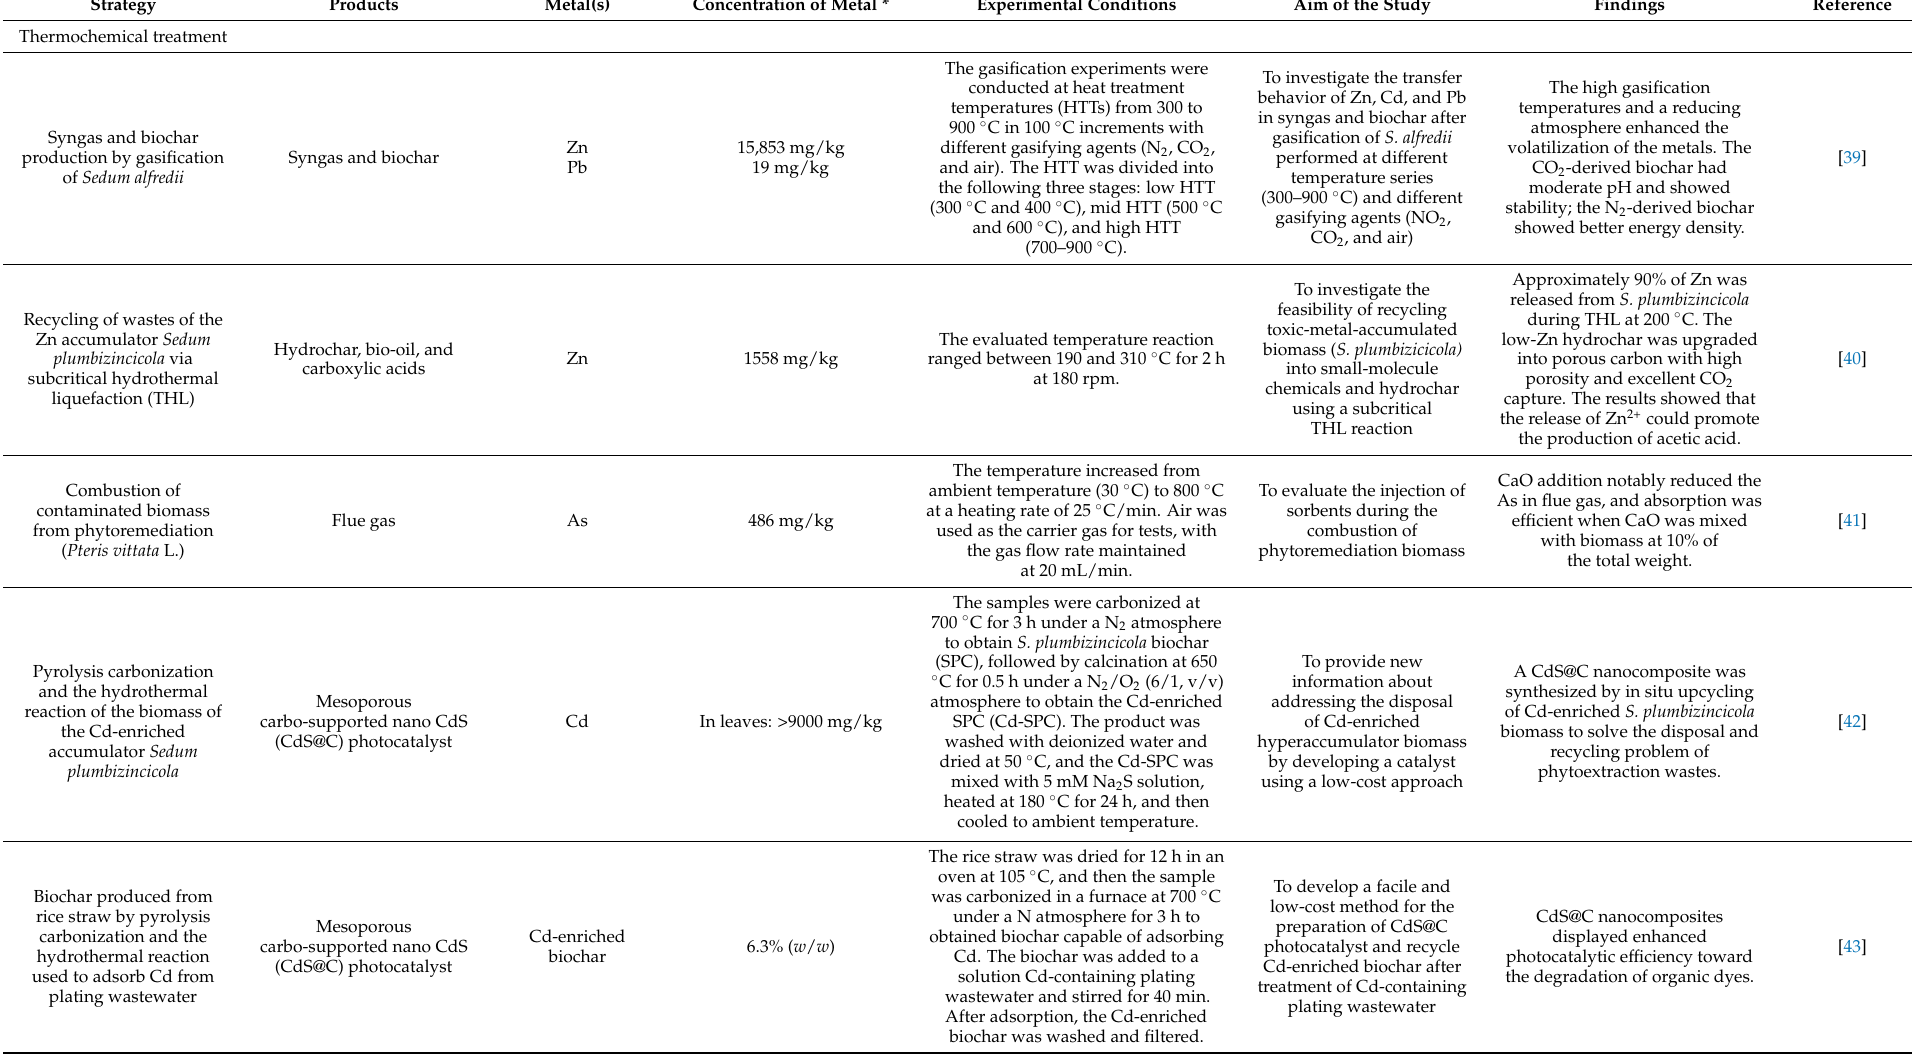
Table 2. Studies focused on the development of strategies to manage biomass